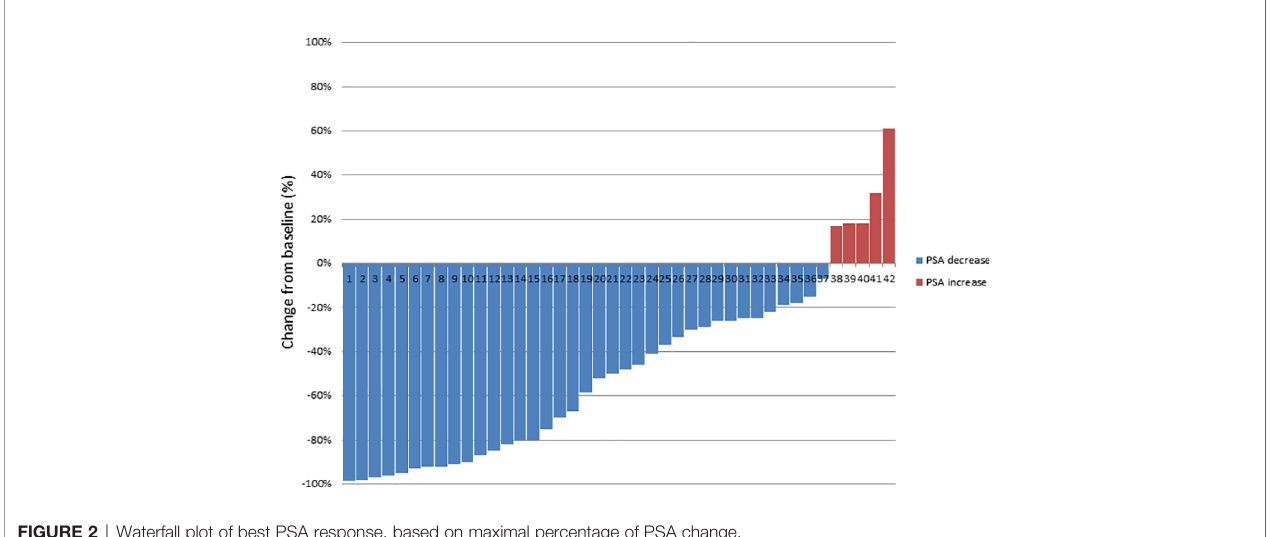
FIGURE 2 | Waterfall plot of best PSA response, based on maximal percentage of PSA change.